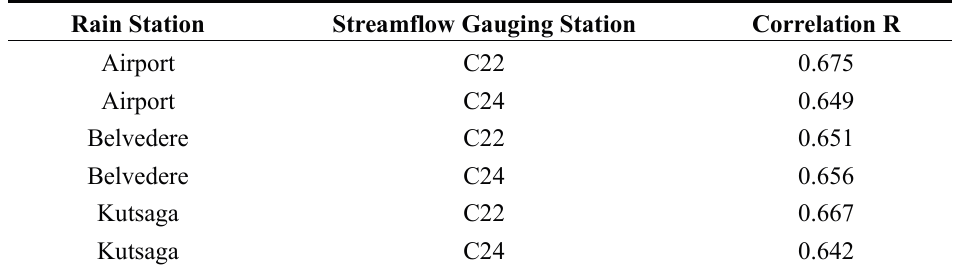
Table 1. The significant relationship ( p < 0.05) between rainfall and streamflow in the study area. All p values were equal to 0.000.